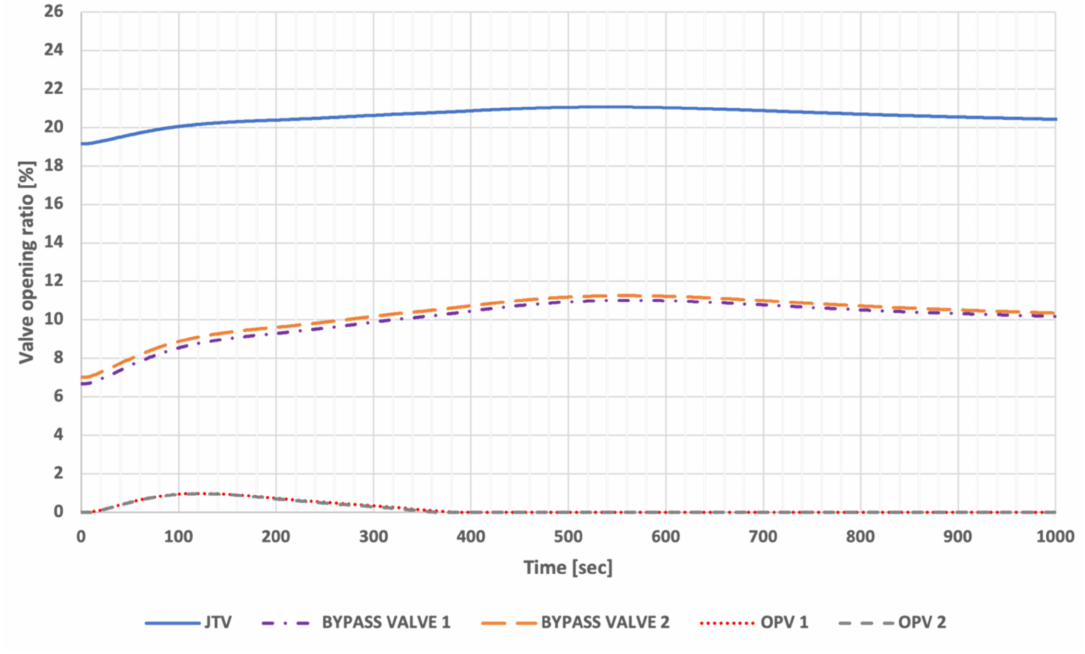
Figure 10. Valve opening ratio when one engine is tripped.